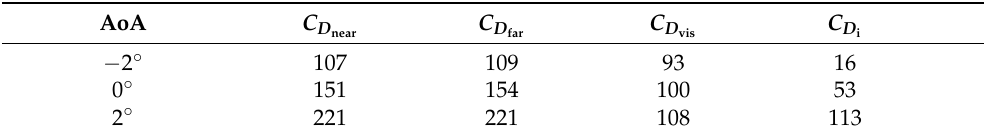
the drag polars without spurious drag detection; induced drag computed by Maskell’s formula.